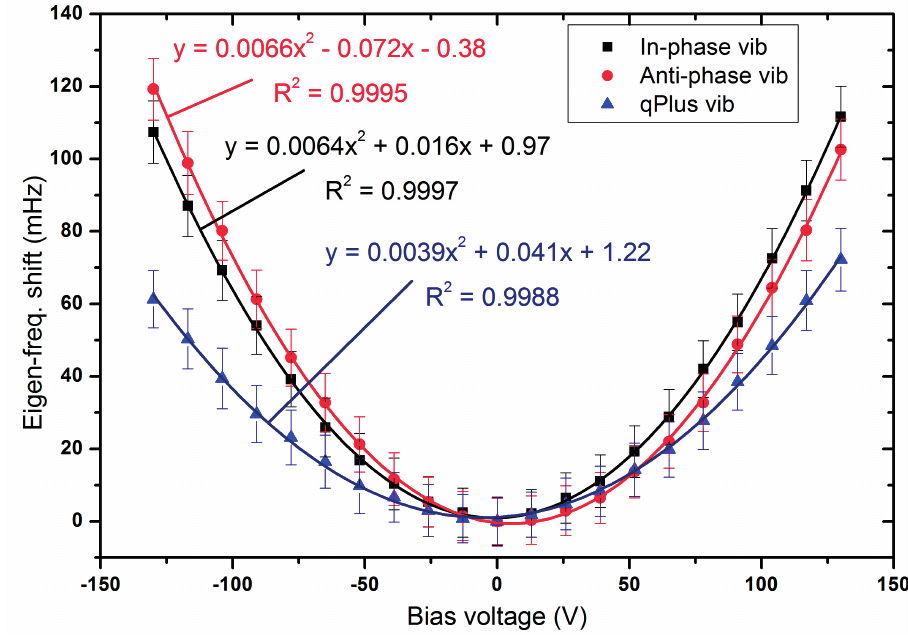
Figure 2. Plots of the eigen-frequency shifts vs . the applied bias voltages for the three different prong vibration modes. Error bars: ±1 standard deviation. The data of each vibration mode can be fitted well with a parabolic